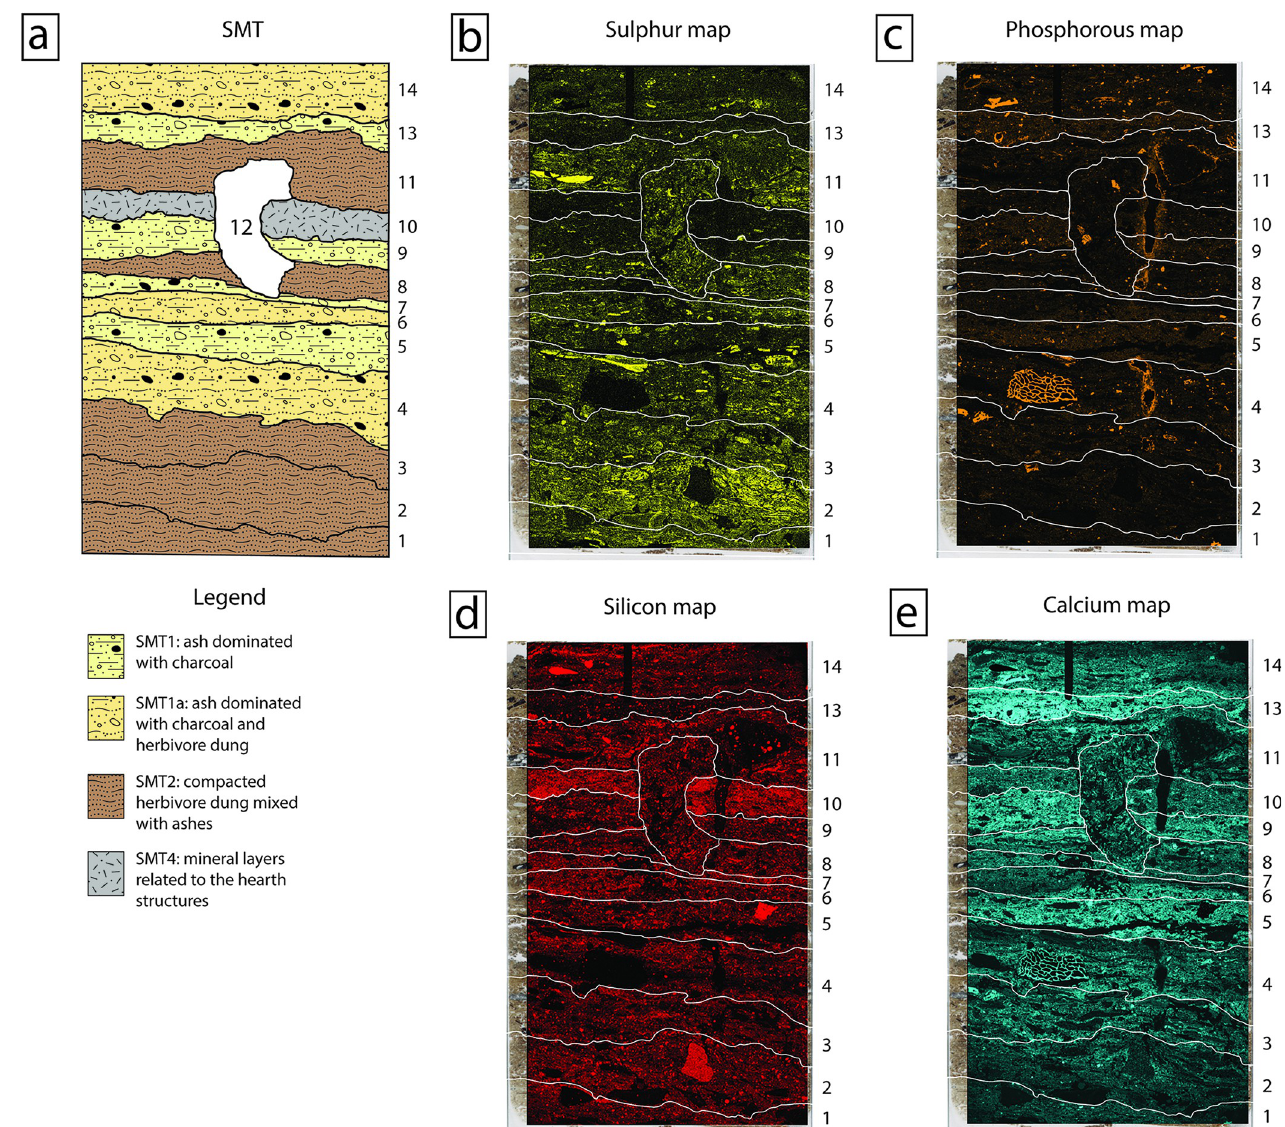
Fig 8. Interpretation of thin section OPP 76 (structure F) and related μ XRF map. (a) Interpretation of thin section OPP 76, with a SMT assigned to each identified sub-unit. Note the alternating sequence of SMT 2 (dung mixed with ashes) and SMT 1 (ash mixed with charcoal)/SMT 1a (ash mixed with herbivore dung and charcoal). Non-interpreted version of thin section OPP 76 is available in S1 Appendix; (b-e) μ XRF maps showing the abundance of specific elements superimposed on the PPL scan of thin section OPP 76. In (b), note the correspondence between high S signal and SMT 2 sub-units and–in minor amount– SMT 1a sub-units that still contain fragments of herbivore dung. In (c) and (e), note that the highest concentrations of P and Ca are visible in SMT 1 sub-units (n˚ 5, 9, 13), while SMT 2 sub-units show very low P values. In SMT 2, the coarse elements with high P signal are bone